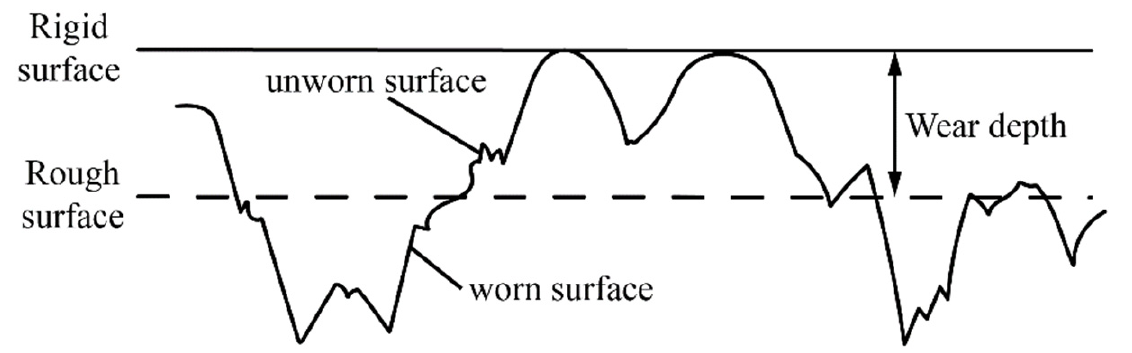
Figure 1. Schematic of wear characterization of rough surfaces.